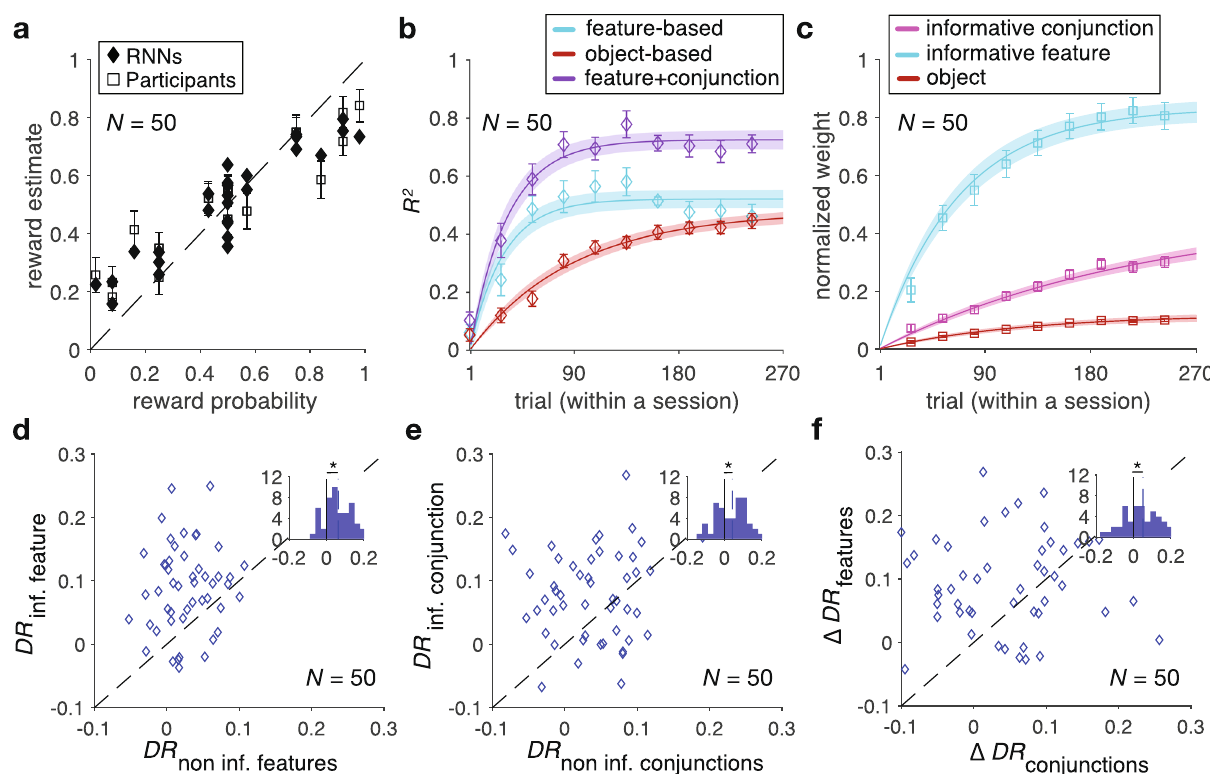
Fig. 5 RNNs can capture main behavioral results. a Plotted are average estimates at the end of a simulated session of our learning task for N = 50 instances of the simulated RNNs and the average value of participants ’ reward estimate vs. actual reward probabilities associated with each stimulus (each symbol represents one stimulus). Error bars represent s.e.m., and the dashed line is the identity. b The plot shows the time course of explained variance ( R 2 ) in RNNs ’ estimates based on different GLMs. Error bars represent s.e.m. The solid line is the average of exponential fi ts to RNNs ’ data, and the shaded areas indicate ±s.e.m. of the fi t. c Time course of adopted learning strategies measured by fi tting the RNNs ’ output using a stepwise GLM. Plotted is the normalized weight of the informative feature, informative conjunction, and object (stimulus identity) on reward probability estimates. Error bars represent s.e.m. The solid line is the average of exponential fi ts to RNNs ’ data, and the shaded areas indicate ±s.e.m. of the fi t. d Plot shows differential response for the informative feature vs. differential response for the non-informative features in the trained RNNs. The inset shows the histogram of the difference between differential response of the informative and non-informative features. The dashed line shows the median values across all trained RNNs, and an asterisk indicates the median is signi fi cantly different from 0 (two-sided sign-rank test; P = 0.013). e Similar to d but for the informative and non- informative conjunctions (two-sided sign-rank test; P = 1.4 × 10 − 6 ). f Plot shows the difference between differential response for the informative and non- informative features vs. the difference between differential response for the informative and non-informative conjunctions. The inset shows the histogram of the difference between the aforementioned differences (two-sided sign-rank test; P = 0.018). Source data are provided as a Source Data fi